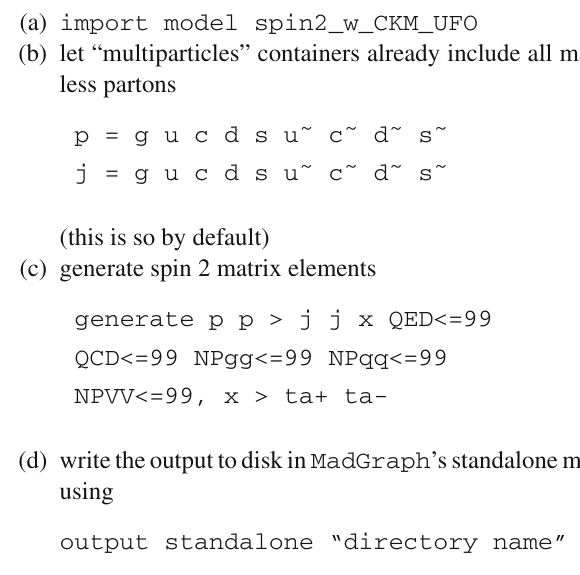
W ± ’s, Z ’s and gluons; the explicit formulas for those